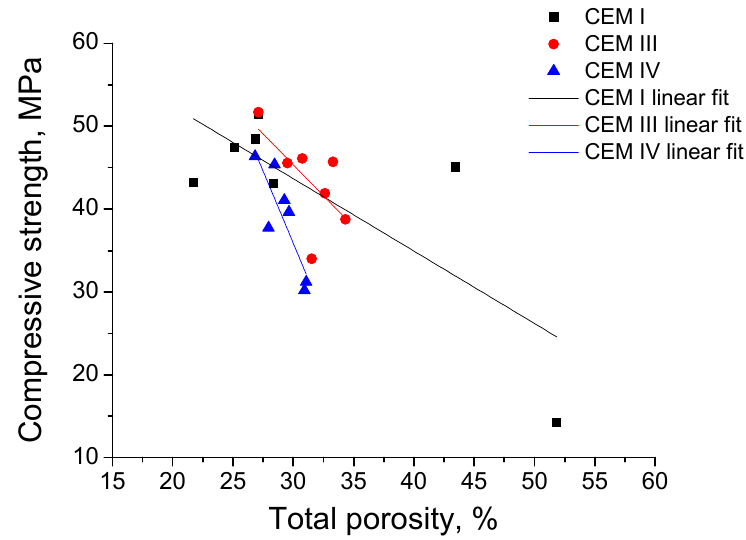
Figure 12. Relationship between compressive strength and total porosity for CEM I, III and IV grouts.